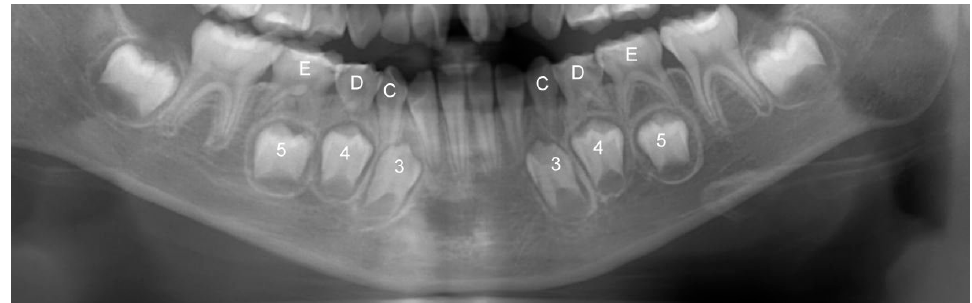
Figure 1. Panoramic image of deciduous teeth and permanent teeth in the lower jaw of one patient. According to clinical naming convention, 3, 4, and 5 indicates primary canines and first and second molars as well as C, D, and E represents permanent canines and two premolars. The difference between the mesiodistal crown widths of 345 and CDE is the value of leeway space.